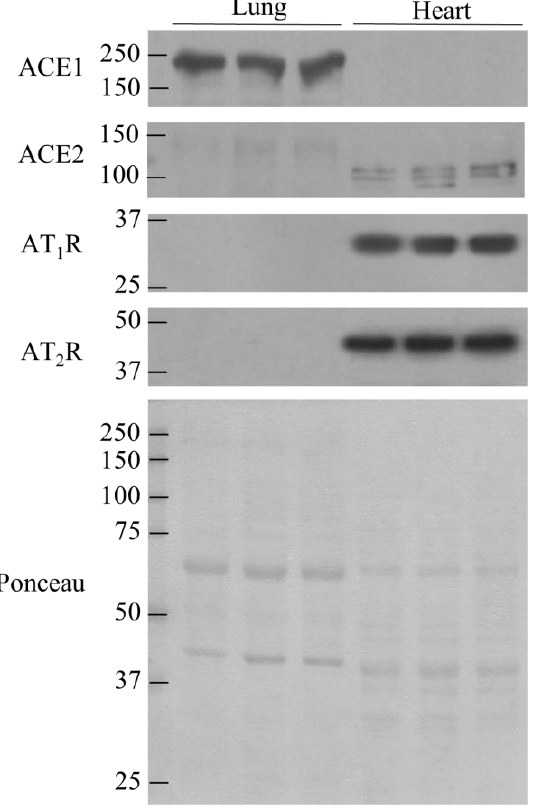
Figure 3. AT 1 R, AT 2 R and ACE2 are more abundant in heart tissue than in lung tissue. In contrast, lung tissue contains more ACE1. n = 3.